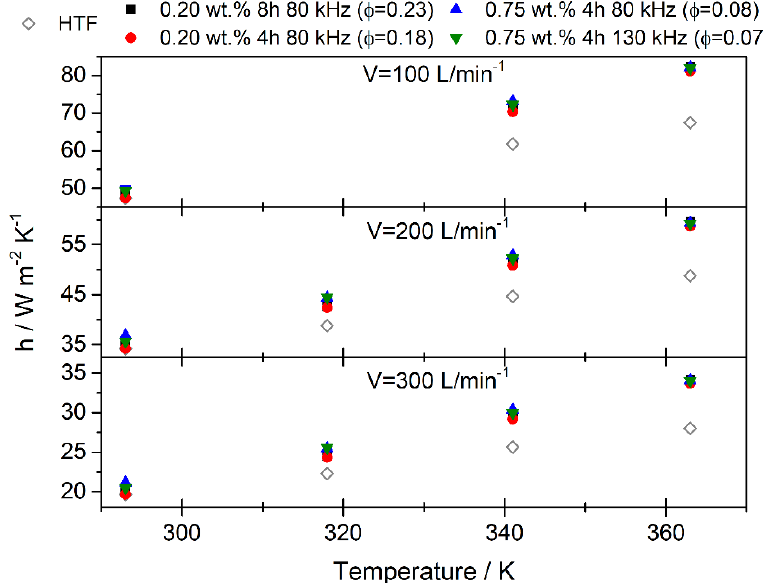
Figure 8. Heat transfer coefficients for 2D-WS 2 nanofluids and HTF for three flow rates, 100, 200 and 300 L/min.